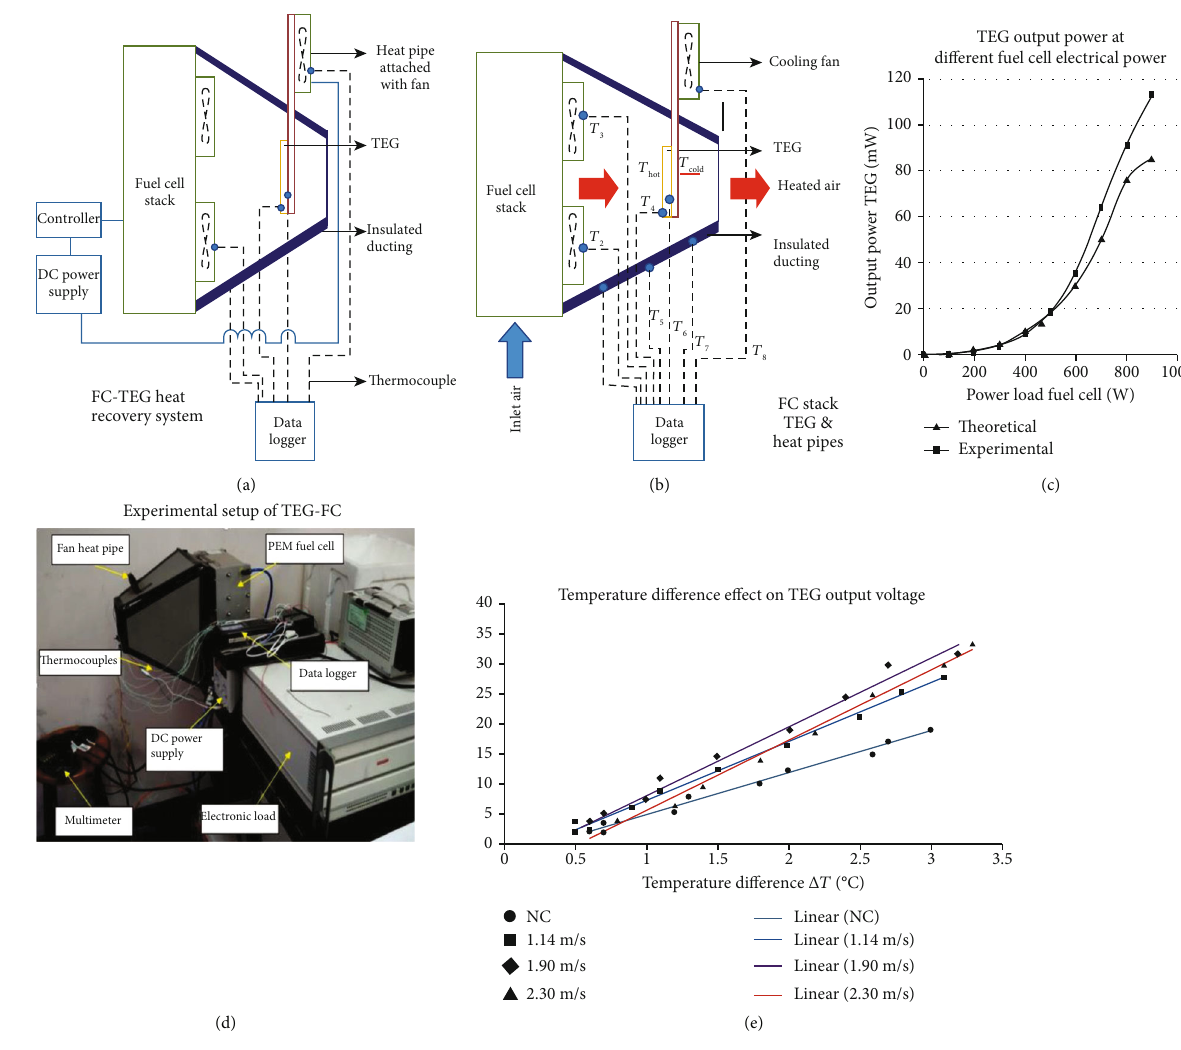
Figure 12: TEG and 1 kW LT-PEM FC waste heat recovery system (adapted from